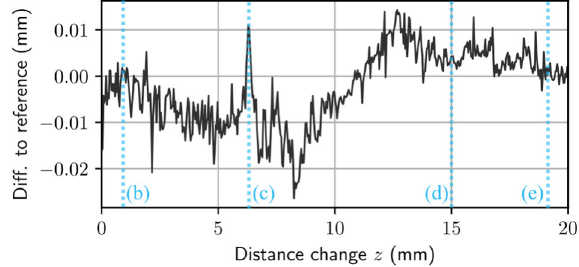
Fig. 2. Measurement result plotted as error over distance change. The error is calculated as the difference between measured distance and the linear stage position (reference). The blue dotted lines (b) to (e) refer to the images of Fig. 3 (b) to (e).